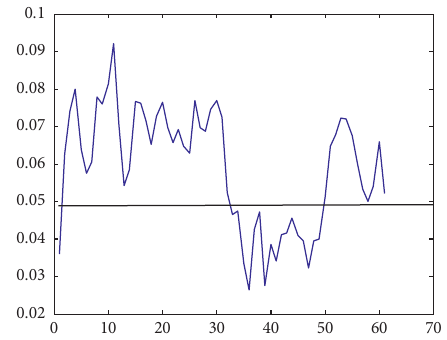
Figure 7: A simulated interest rate path of the jump-diffusion model.